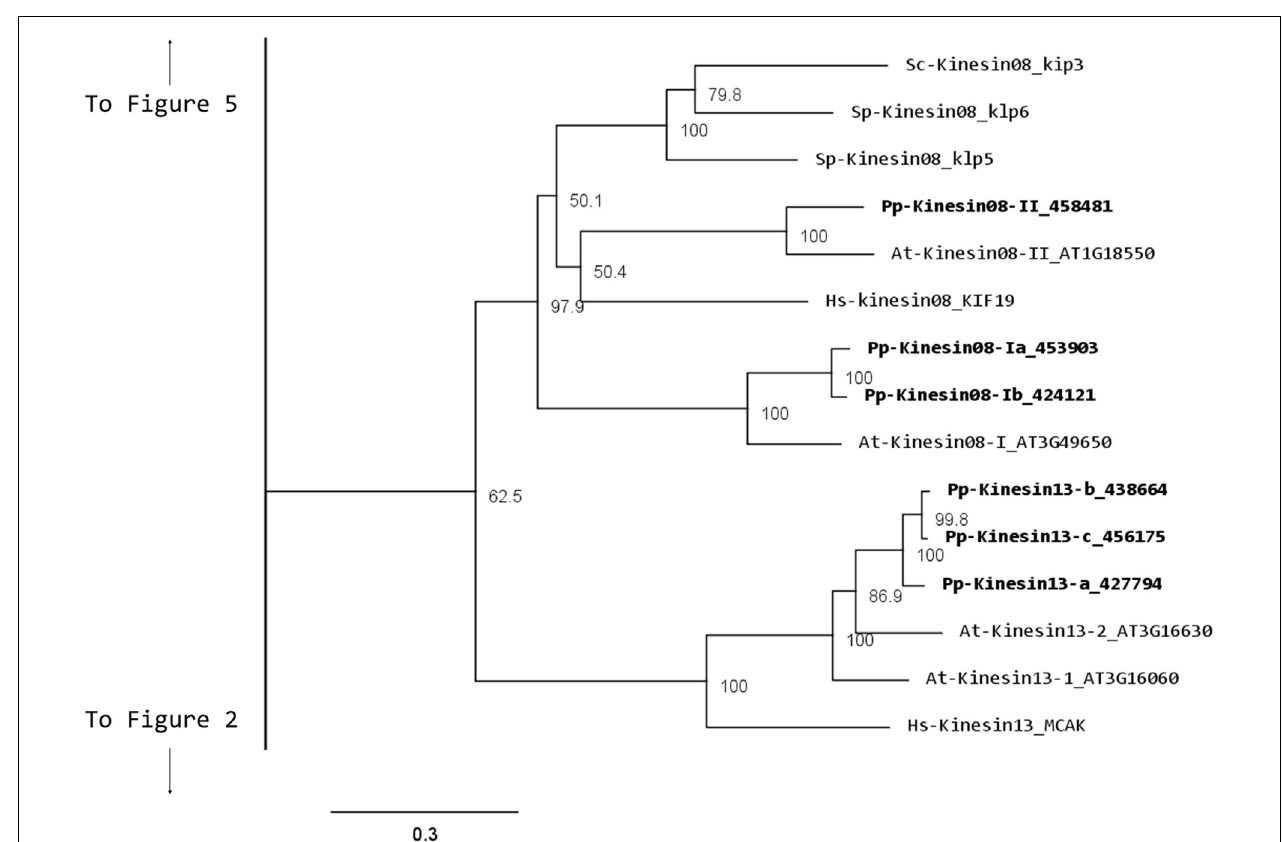
the nodes show the statistical support of values above 50%.The scale shows the estimated branch length corresponding to the number of substitutions per site.The Physcomitrella numbers correspond to the Phypa number uniquely associated with each gene model (version 1.6) at